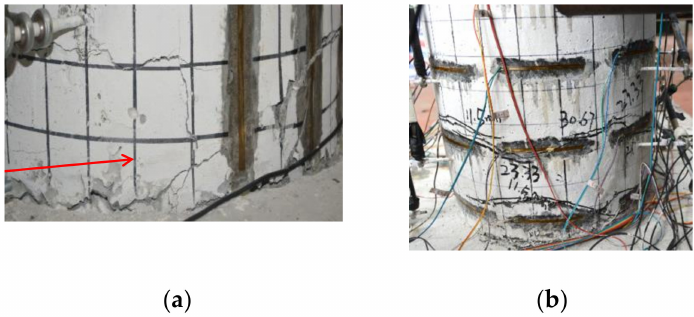
Figure 17. Damage at the end of the cyclic tests on: ( a ) The ASB column and ( b ) the RR